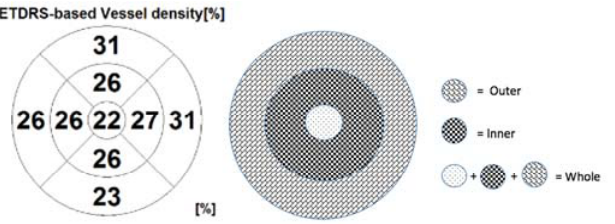
Figure 2. The ETDRS-based vessel density [%], with division of the macular area into the nine ETDRS subfields (on the left). On the right, a scheme showing the rings centered around the fovea. The fovea is defined as the area within the central 1-mm ring of the Early Treatment Diabetic Retinopathy Study (ETDRS) grid. The surrounding ring with an inner diameter of 1 mm and an outer diameter of 3 mm is considered as the inner ring. The ring with an inner diameter of 3 mm and an outer diameter of 6 mm is considered as the outer ring. The whole ring includes the fovea and the inner and outer rings.